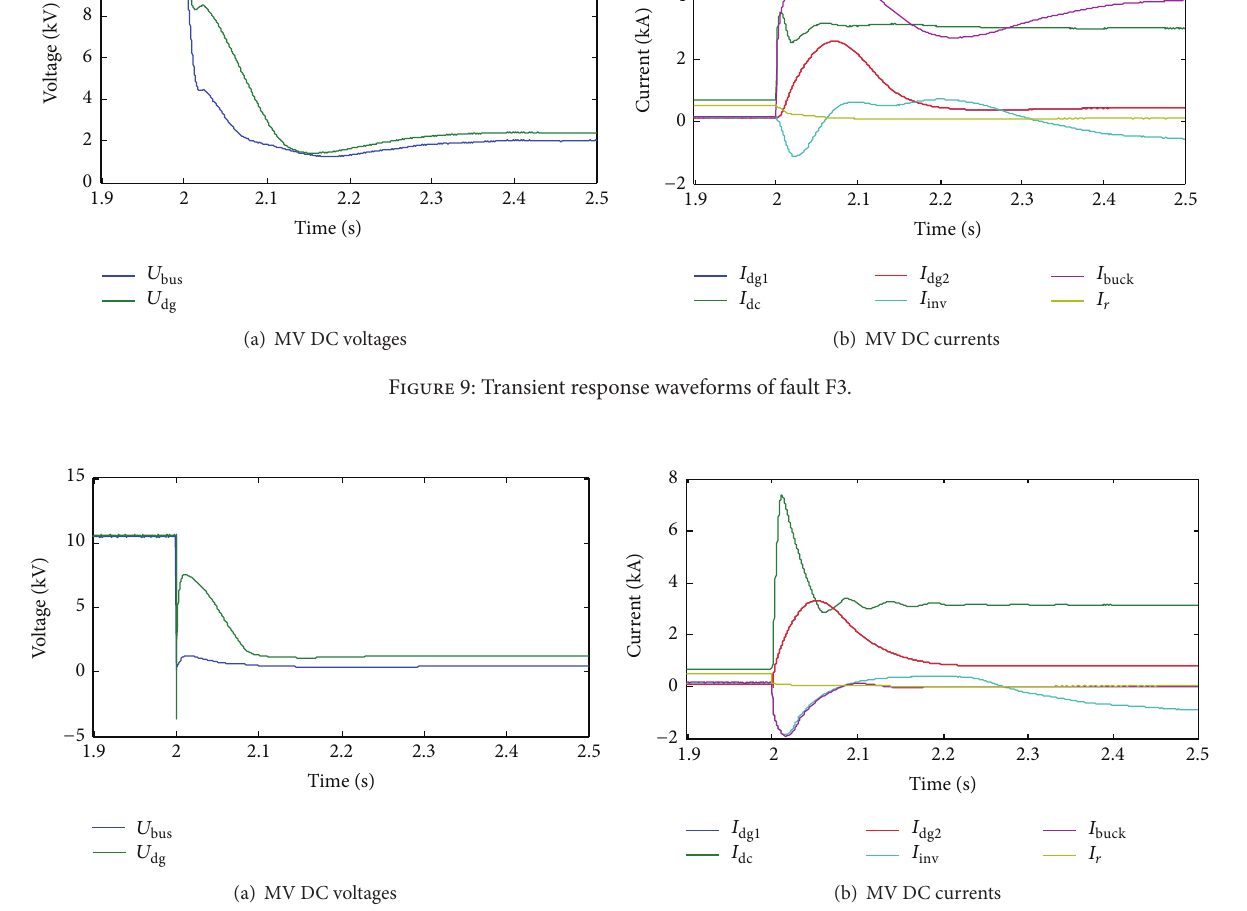
Figure 10: Transient response waveforms of fault